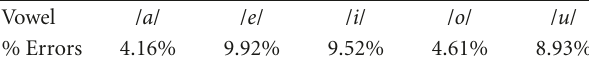
Table 3: Rate of mispronunciations per